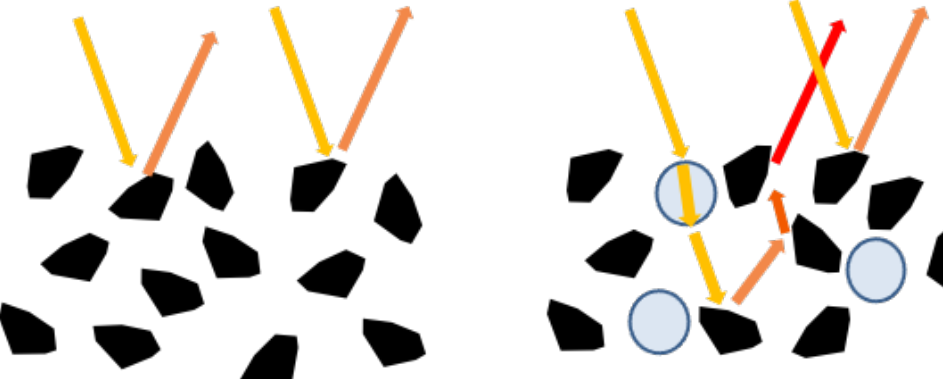
Figure A3. Schematization of the “light-trapping” induced by transparent forward-scattering water ice grains (clear circles) mixed with opaque back-scattering pyrrhotite grains (black irregular shapes). Arrows indicate the propagation of photon packets, and colour shades from yellow to red indicate increasing levels of the fraction of absorbed